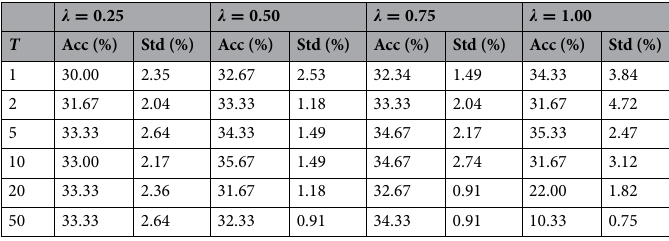
Table 5. Temporal relation networks (TRN) 22 with subjects consensus.